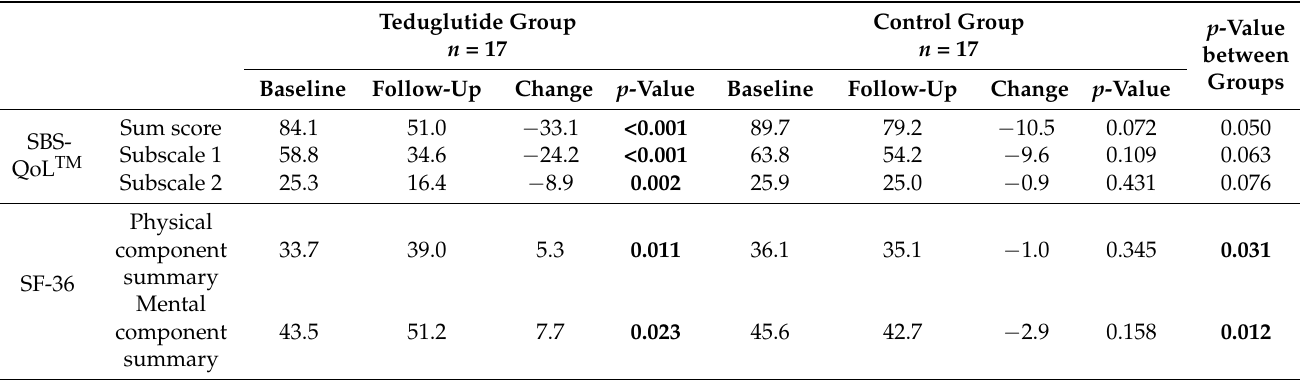
Table 3. QoL analyses over time and between groups. Presented are means for better comparability to previous literature. Change: follow-up to baseline. SF-36: positive changes representing QoL improvement; SBS-QoL TM : negative changes representing QoL improvement.